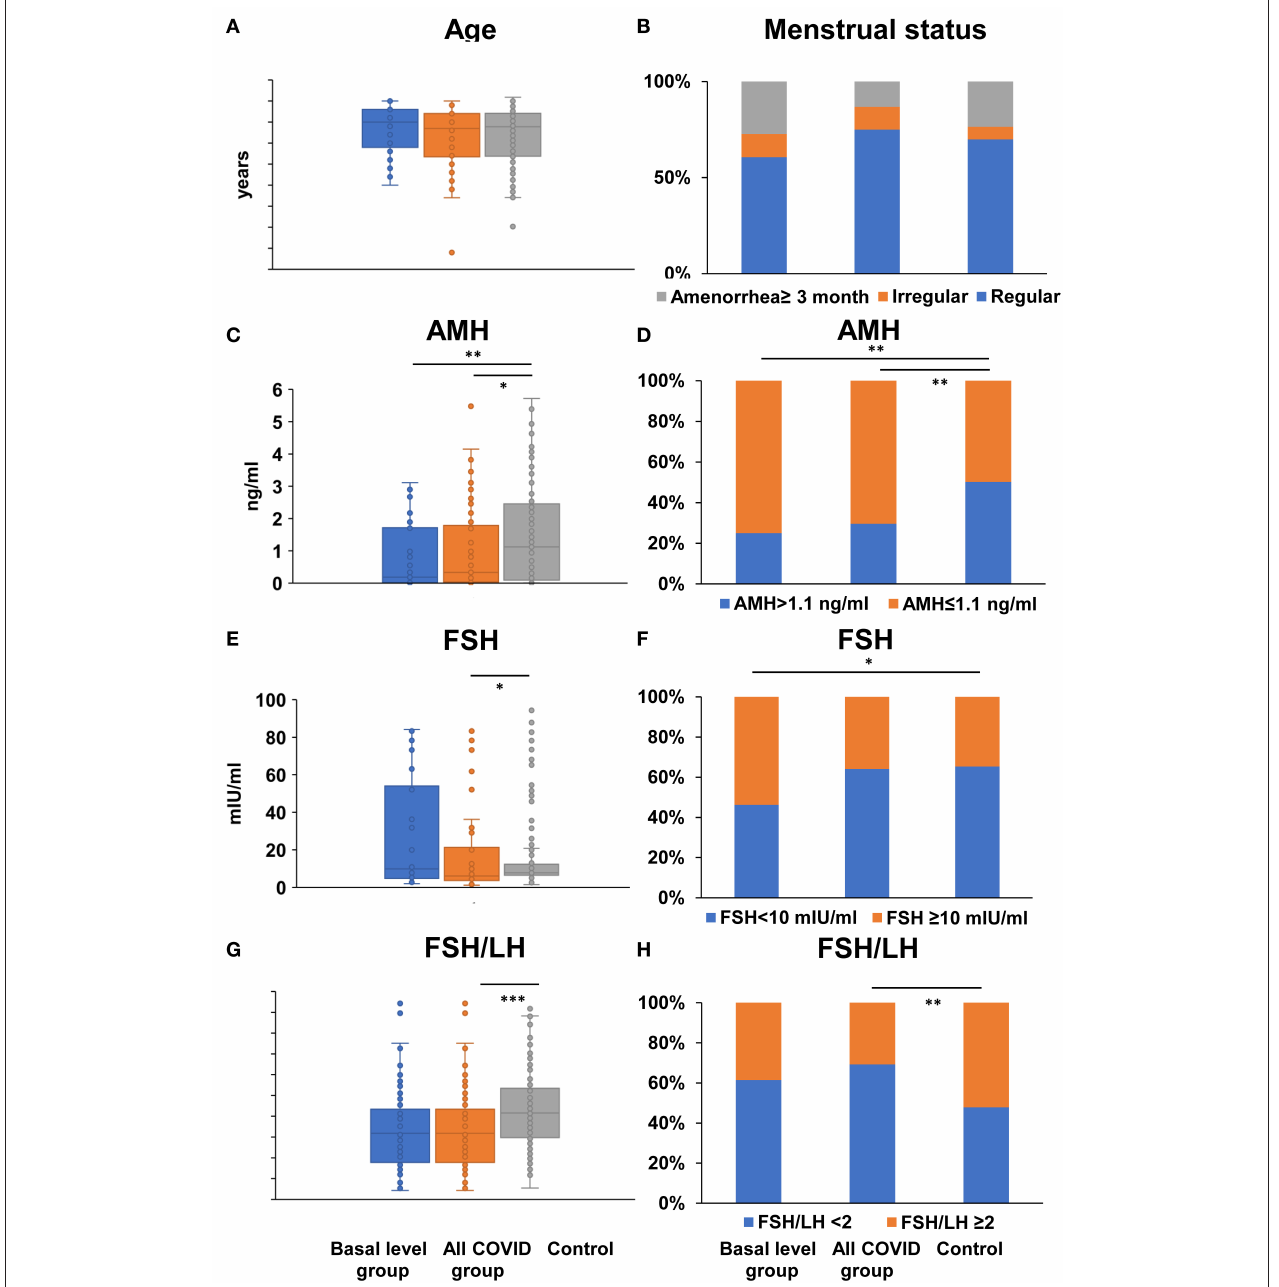
FIGURE 2 | Comparison of age, menstrual status, and ovarian reserve tests between COVID-19 patients and healthy women. Differences of age (A) , menstrual status (B) , serum AMH (C) , FSH level (E) , the ratio of FSH to LH (G) , the proportion of AMH ≤ 1.1ng/ml (D) , FSH ≥ 10 mIU/ml (F) , FSH/LH ≥ 2 (H) were compared between basal level/all COVID-19 group and healthy control women; * P < 0.05 ** P < 0.01 *** P < 0.001.